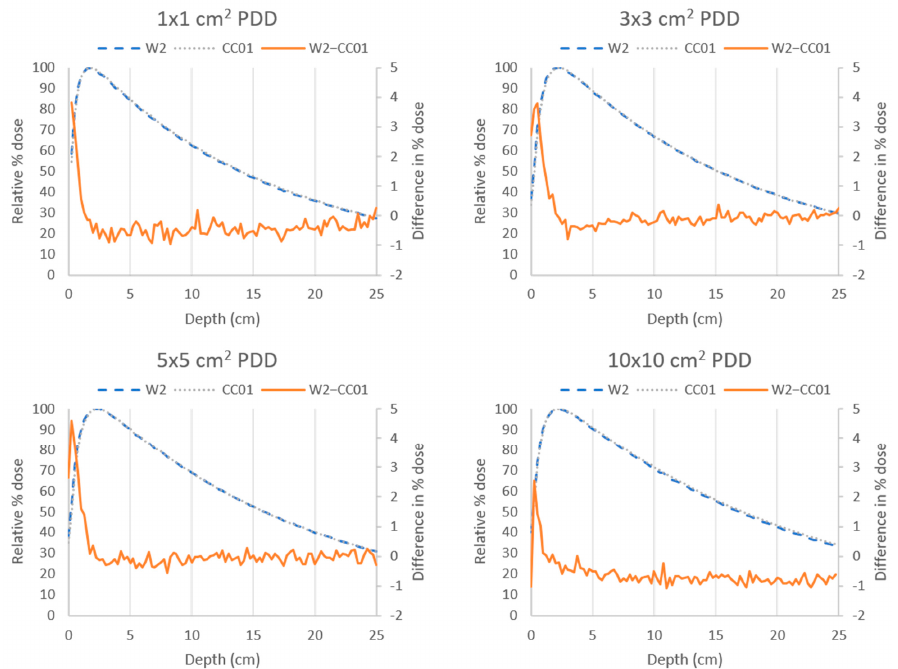
Figure 2. Percent depth dose (PDD) curves measured with the Exradin W2 scintillator (blue) and the CC01 ion chamber (gray) using a 10 MV flattening-filter-free (FFF) beam at 100 cm source-to-surface distance for various field sizes. The difference between the two measurements (W2—CC01, orange) was less than 5% at all points and less than 1% at depths greater than d max . The in-plane profile measurements shown in Figure 3 illustrated a similar agreement between the CC01 ion chamber and the W2 scintillator to that found for the PDD meas- urements. Agreement was within 5% inside the penumbra region, and within 1% outside of the penumbra region. Cross-plane profile measurements showed similar agreement (not shown here).